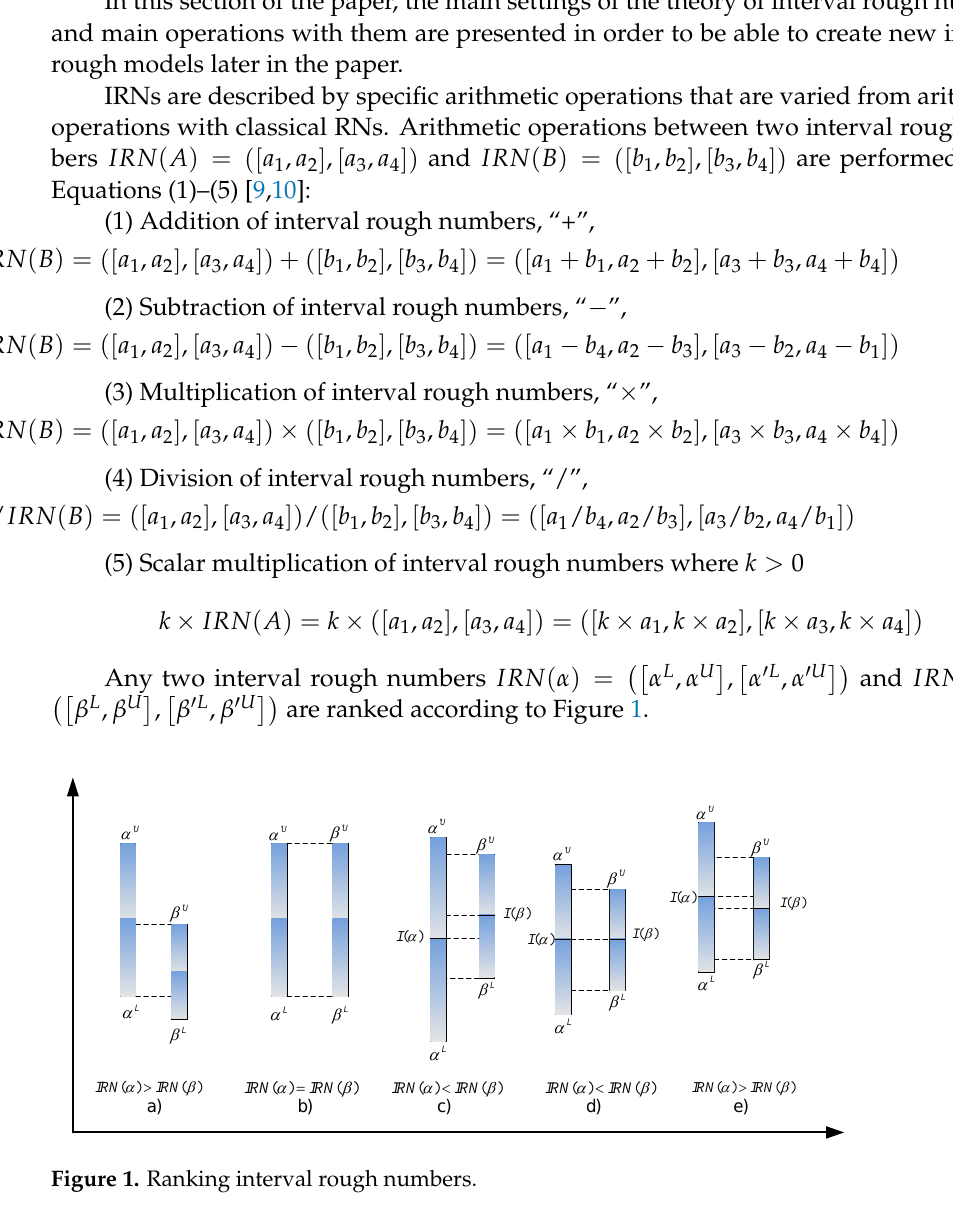
Figure 1. Ranking interval rough numbers.